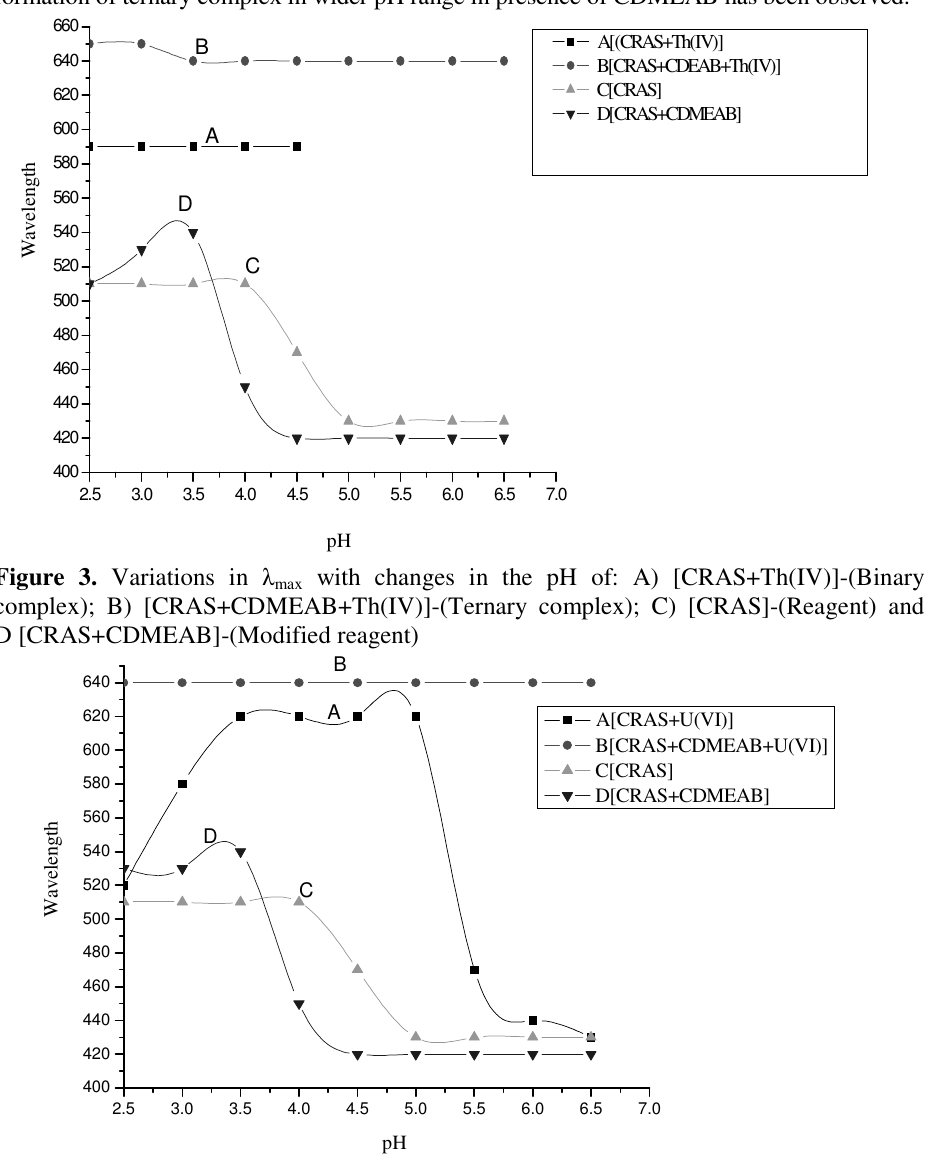
Figure 4. Variations in λ with changes in the pH of: A)[CRAS+U(VI)]-(Binary max complex); B) [CRAS+CDMEAB+ U(VI)]-(Ternary complex); C) [CRAS]-(Reagent) and D) [CRAS+CDMEAB]-(Modified